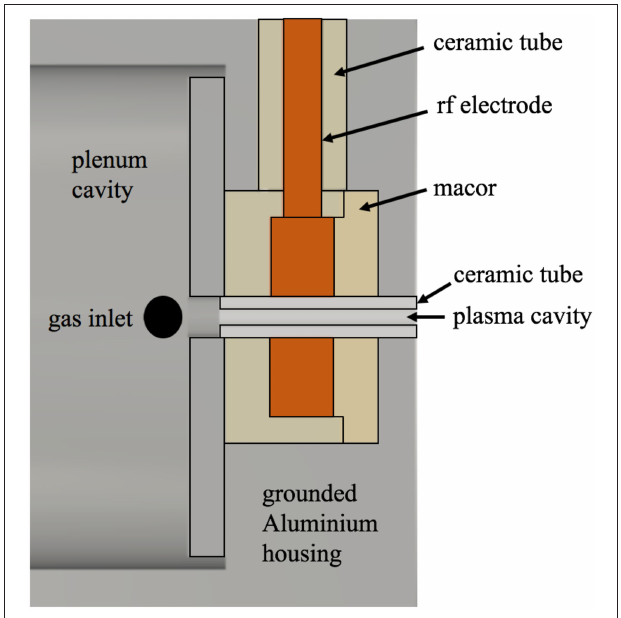
FIGURE 2 | Cartoon showing MiniPR main components.